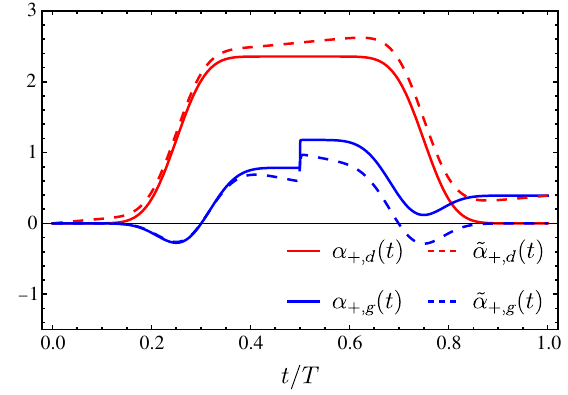
FIG. 8. A comparison of the geometric and dynamical phases generated by state | φ + ( t ) (cid:2) . The variables with (without) a tilde correspond to the dynamical (geometric) T gate.